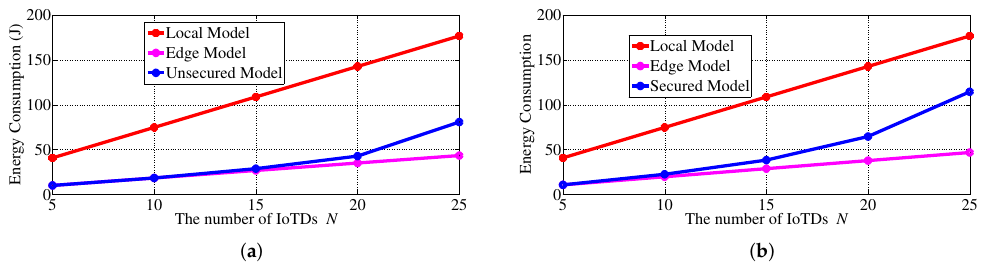
Figure 4. The energy consumption. ( a ) Unsecured model; ( b ) Secured model.